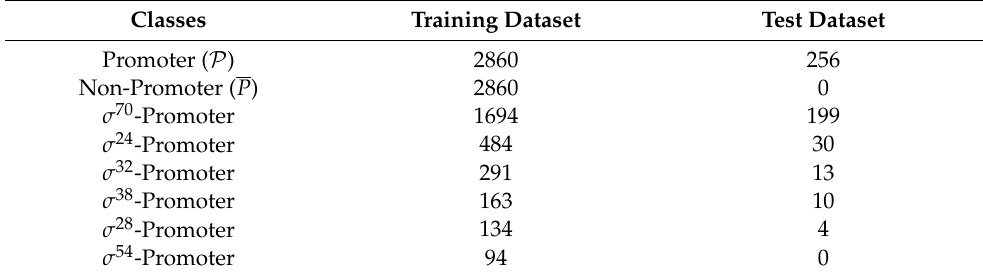
Table 1. Training and test dataset sample